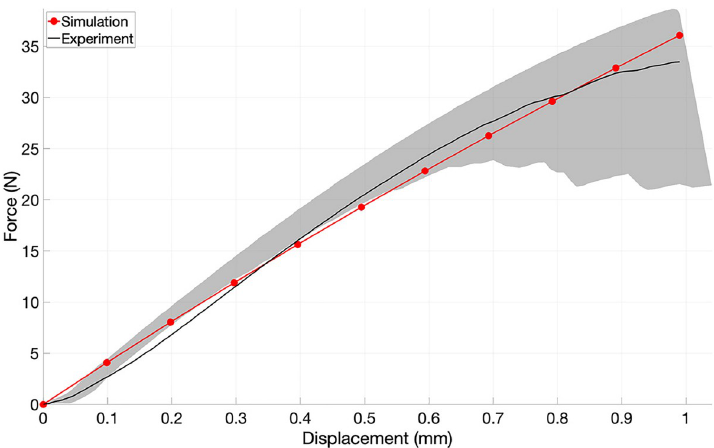
Fig 9. Experimental and simulated force-displacement curves. This is the force-displacement curve using the material constants from the optimisation of the elastic properties. The area between minimum and maximum force- displacement experimental curves are shaded